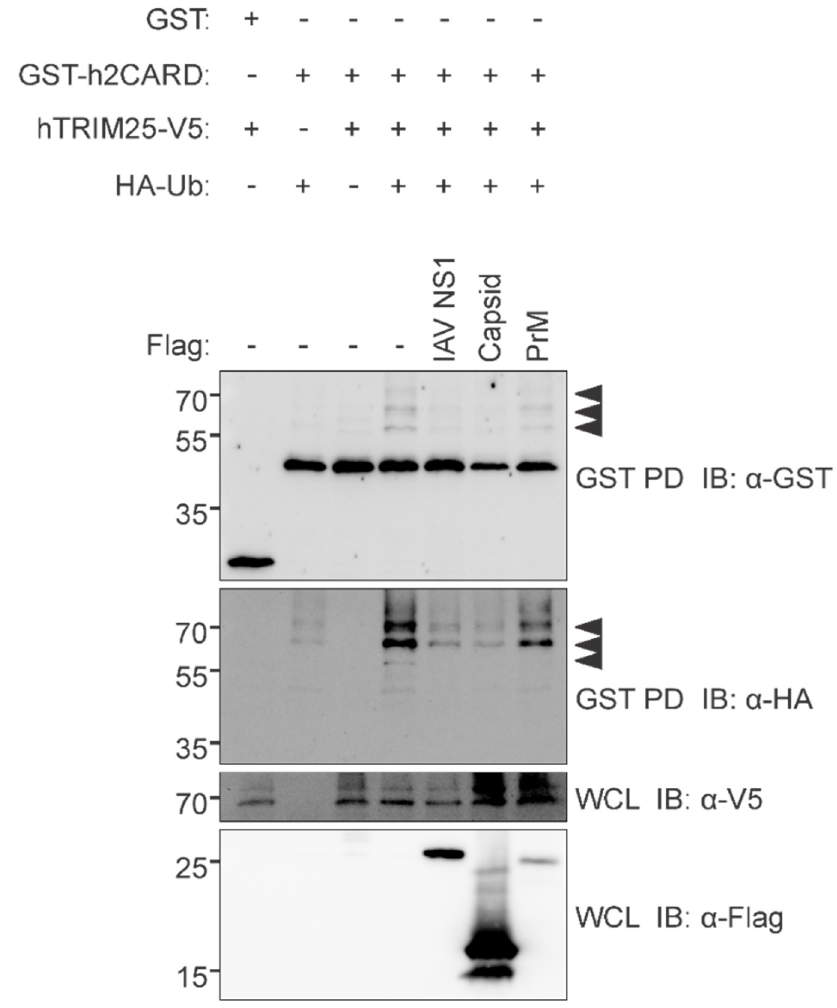
Figure 7. ZIKV capsid inhibits TRIM25 from ubiquitinating RIG-I. HEK293T cells were transfected with GST-tagged human RIG-I CARD domains (GST-h2CARD) or empty GST vector, together with HA-tagged ubiquitin (HA-Ub), V5-tagged human TRIM25 (hTRIM25-V5), and the indicated Flag- tagged proteins. Clarified whole cell lysates (WCL) were subjected to GST pulldown (GST PD), followed by immunoblotting (IB) with anti-GST, anti-HA, anti-V5, and anti-Flag antibodies. Influenza A virus (IAV) NS1 serves as a positive control for ubiquitination inhibition.